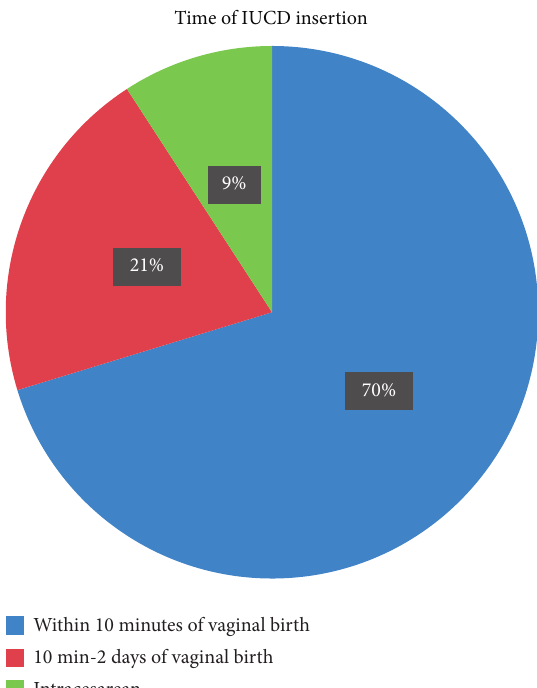
Figure 2: Time of insertion of the postpartum intrauterine contraceptive device among respondents delivering in public hospitals of South Gondar, Ethiopia, 2019 ( n � 140). Other � includes family, relatives, and friend.